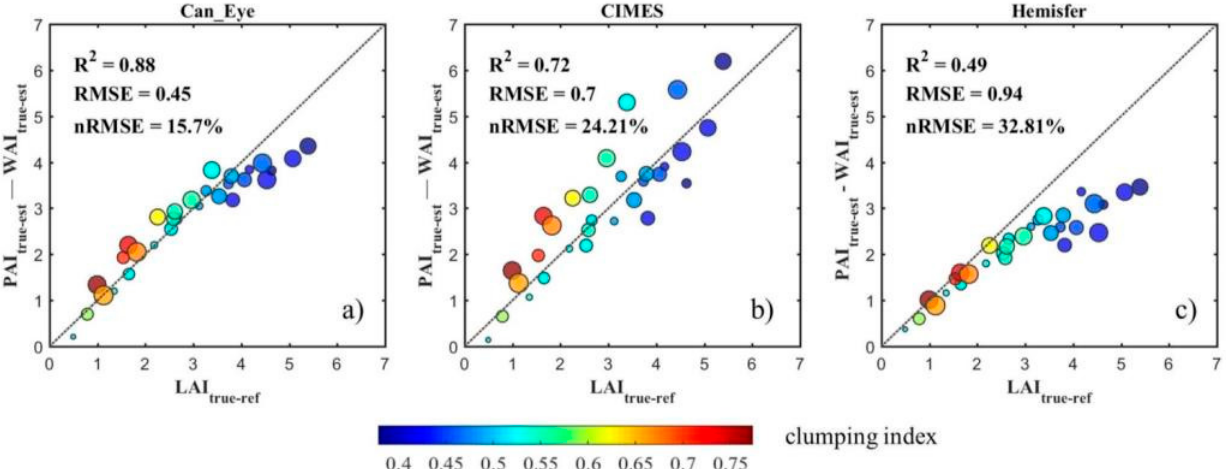
Figure 10. Accuracy of the true leaf area index estimates (LAI true-est , calculated from PAI true-est minus WAI true-est ) using three digital hemispherical photography programs including ( a ) Can_Eye, ( b ) CIMES, and ( c ) Hemisfer compared to ground reference values (LAI true-ref ). A smaller symbol indicates a smaller average leaf inclination angle (ALA) while a larger symbol indicates a higher ALA.